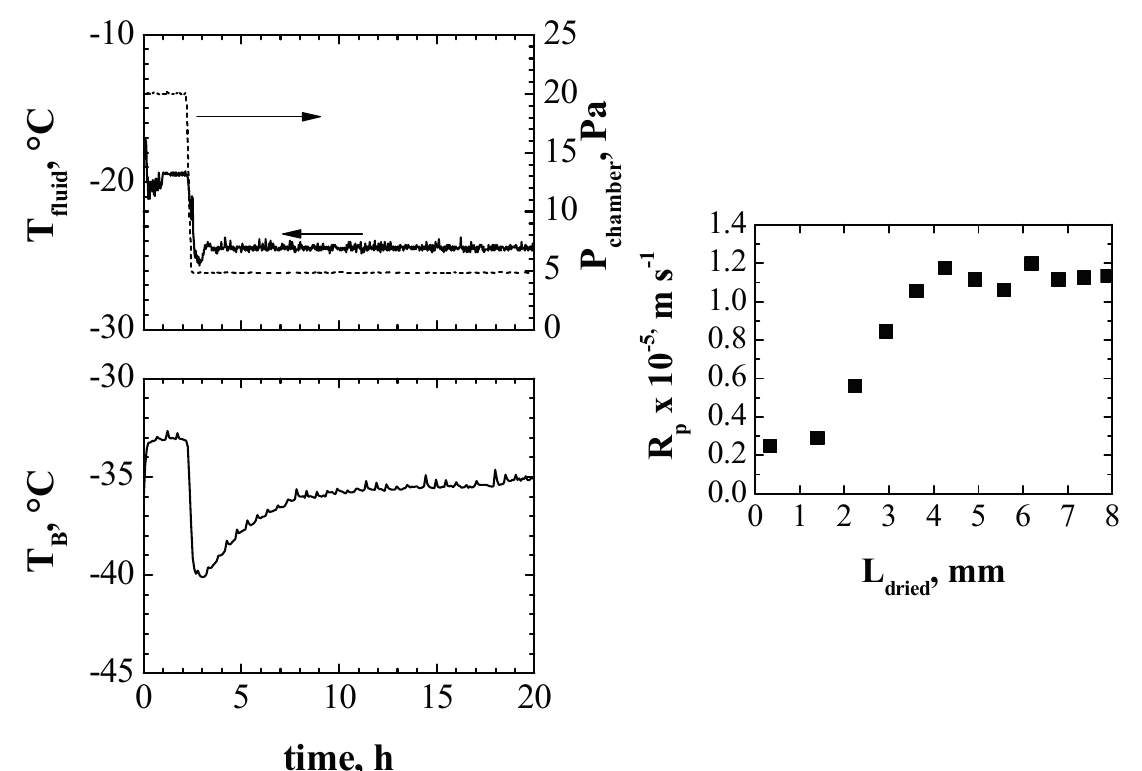
Figure 6. Results obtained in a run where the values T fluid and P c are modified during the primary drying (as shown in the top graph). Values of product temperature measured using a thermocouple and of the dried cake resistance estimated using the pressure rise test are shown in the middle and in the bottom graph